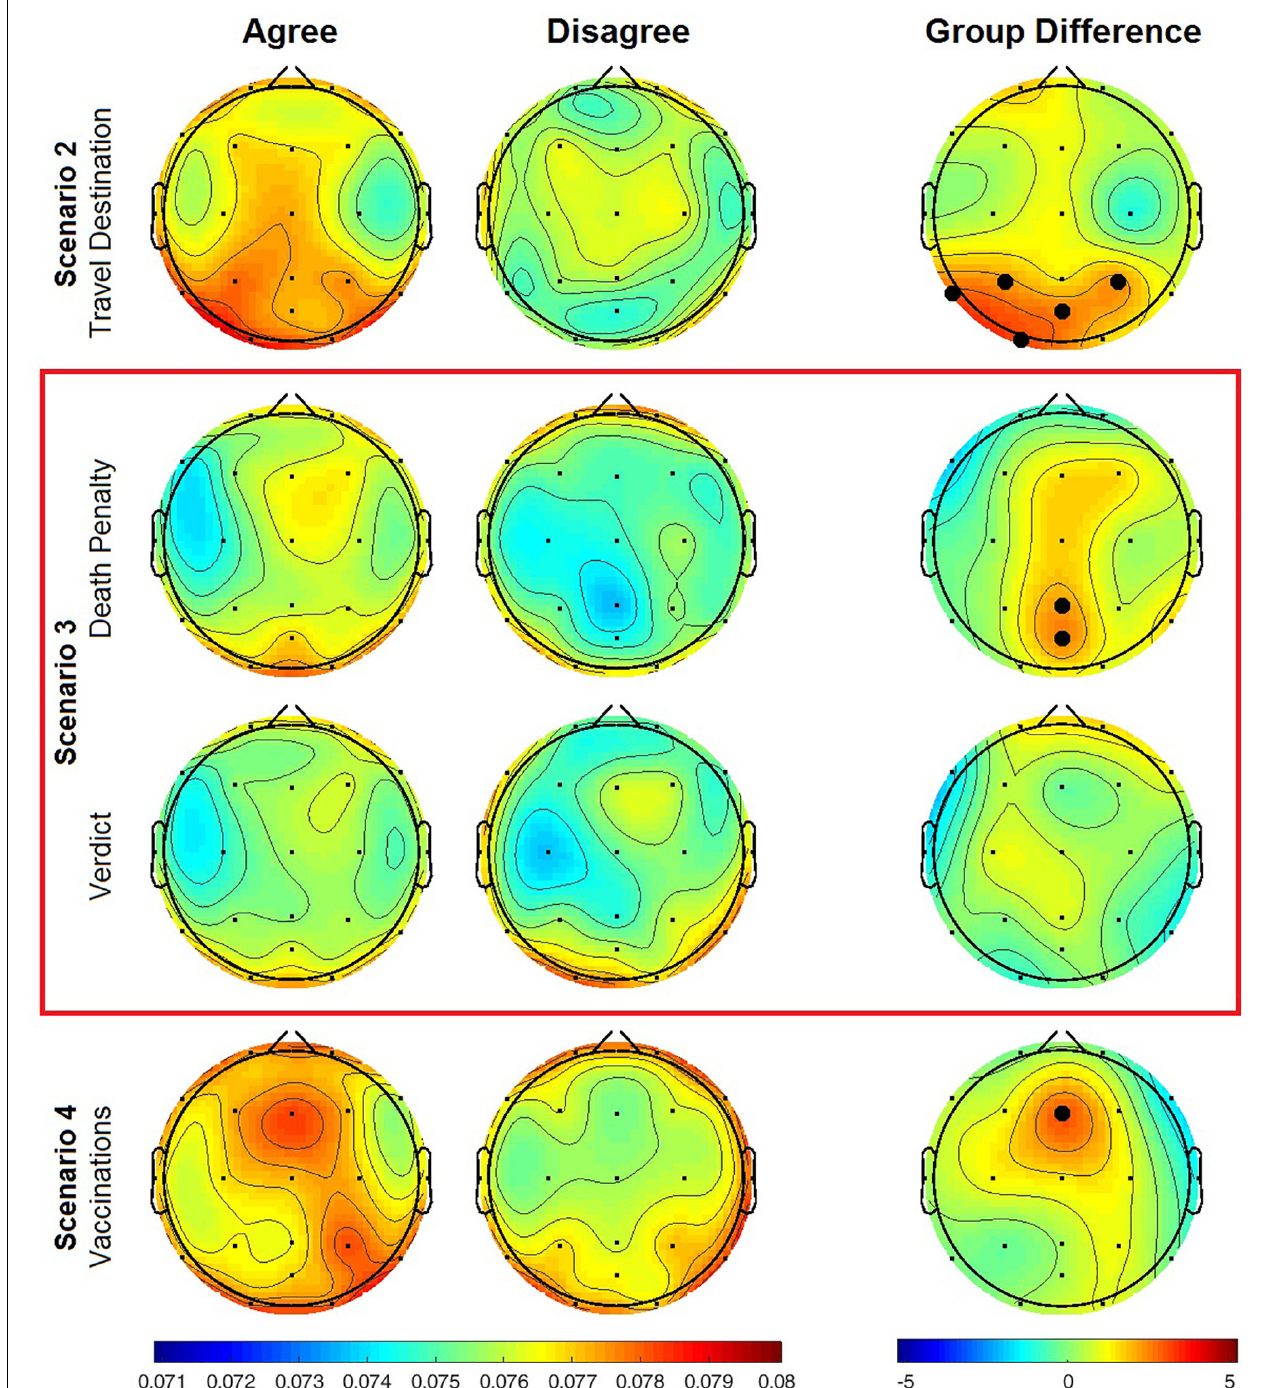
FIGURE 2 | Inter-brain coherence by social concordance in gamma frequency band during each scenario. IBC topological maps for agreeing and disagreeing pairs depicted in columns on left with difference between groups in rightmost column. Color bar on bottom left is for agree and disagree groups; bottom right side color bar applies to group difference topological maps with range [-0.0005 to +0.0005]. Red box contains maps for the two issues in scenario 3, concordant or discordant stances on death penalty, and the guilty or innocent verdict for alleged murder suspect. Sample sizes are for number of subject pairs; scenario 2, agree, N = 77, disagree, N = 29; scenario 3 death penalty, agree, N = 52, disagree, N = 17; scenario 3 verdict, agree, N = 81, disagree, N = 25; scenario 4 vaccination, agree, N = 75, disagree, N = 32. EEG channels significant at α denoted by black filled circle. Gamma frequency range, 25–40 Hz.